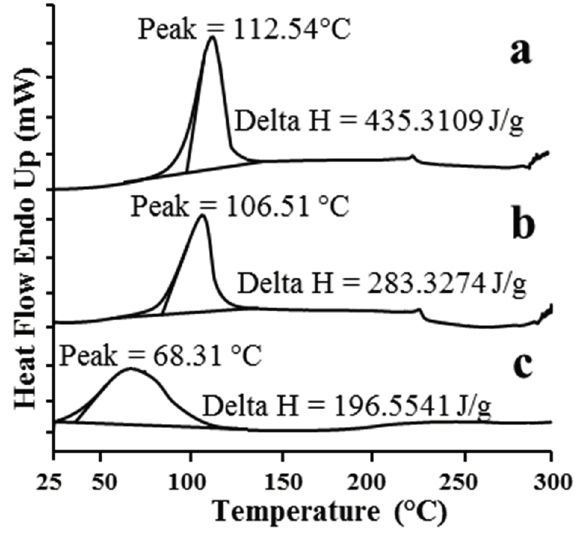
Figure 2. DSC grams of β -CD ( a ); the physical mixture ( b ) and the inclusion complex ( c ).